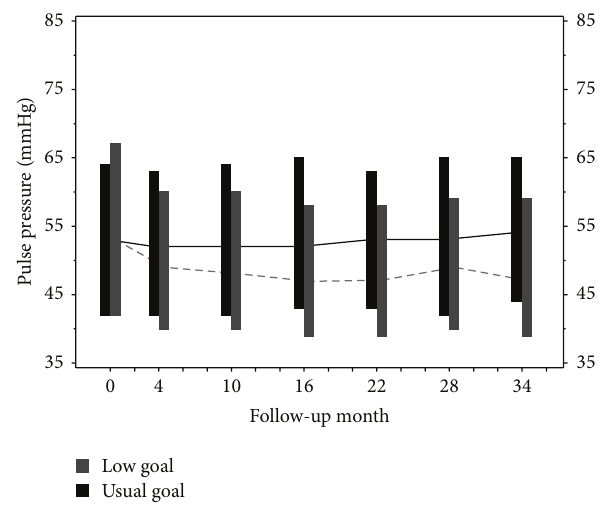
Figure 1: Trend in pulse pressure over time for the low and usual blood pressure groups. The median (connected by horizontal line), 25th percentile (low end of vertical bars) and 75th percentile (upper end of vertical bars) of the pulse pressure measurements at selected follow-up assessments are indicated. All available data were included at each time point. Numbers at the 10-, 22-, and 34-month assessments were 499, 447, and 412 for the low goal and were 497, 433, and 393 for the usual